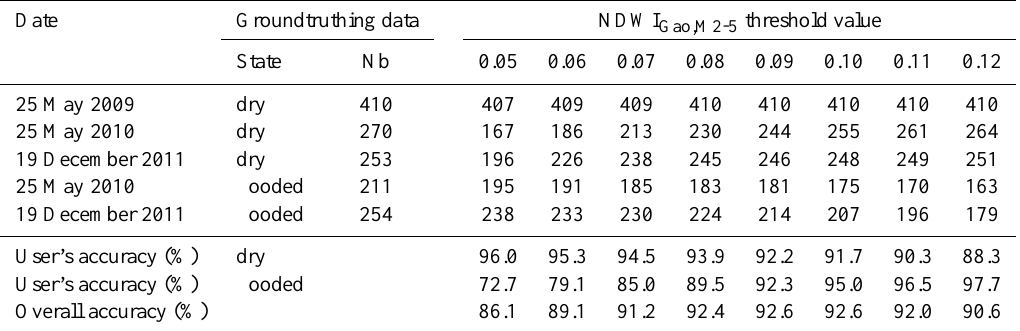
Table 5. Number of correctly classified MODIS pixels at three different dates, compared to the total number of groundtruthing points (Nb) in a dry or flooded state, for different NDWI Gao,M2-5 values. The resulting user’s and overall accuracy are given.